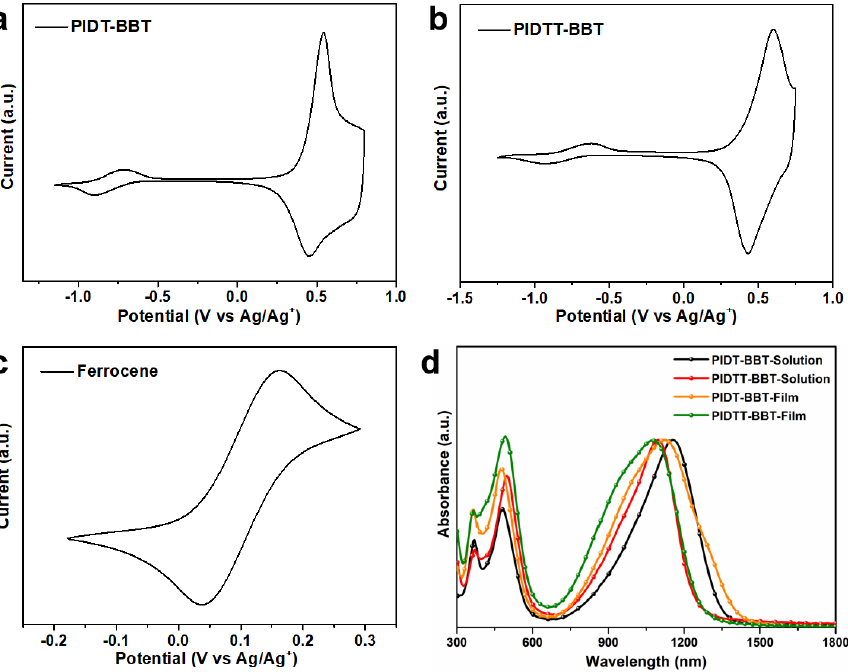
Figure 2. Cyclic voltammograms of solvent-casted ( a ) PIDT-BBT, ( b ) PIDTT-BBT films; ( c ) cyclic voltammograms of ferrocene solutions, and ( d ) UV-vis-NIR absorption spectra of pristine PIDT-BBT and PIDTT-BBT in solution and cast film. Table 1. Electrochemical properties, optical properties, and carrier mobilities of the polymers.